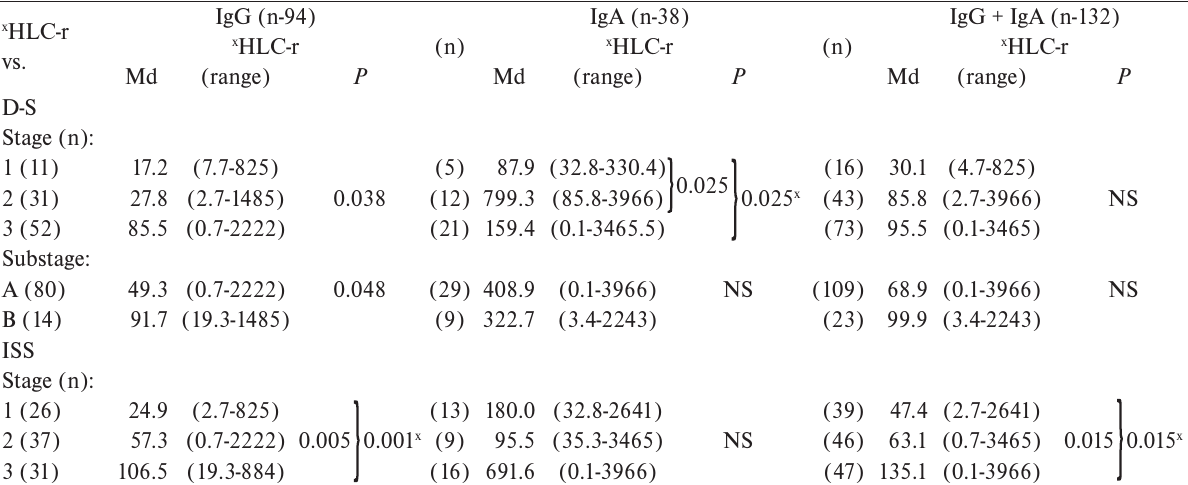
Table 4. Correlations between x HLC-r and multiple myeloma stages classified according to Durie-Salmon and International Staging System in patients with IgG, IgA and IgG plus IgA type of multiple myeloma. x HLC-r